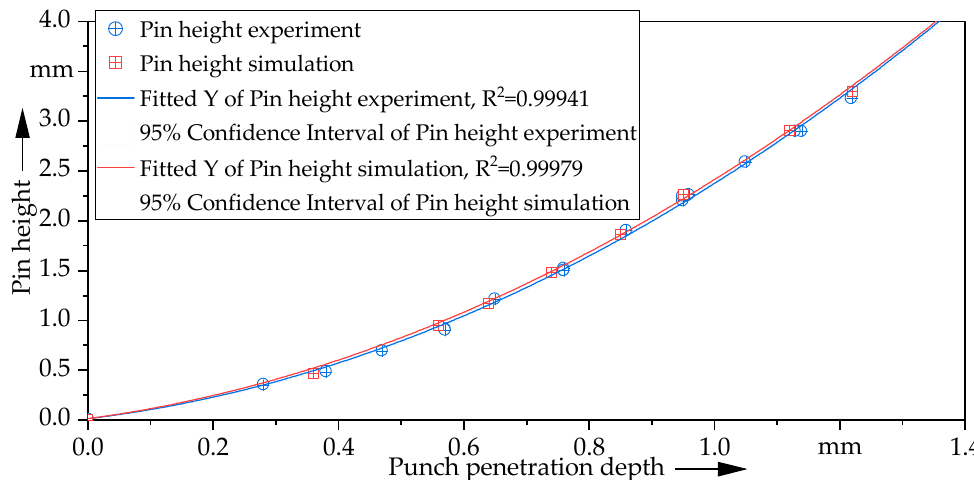
Figure 5. The comparison of the experimentally measured pin heights and punch penetration depths with the pin heights and punch penetration depths determined with the described numerical simulation. Both data sets were fitted with a 2nd grade polynomial to ensure better comparability.